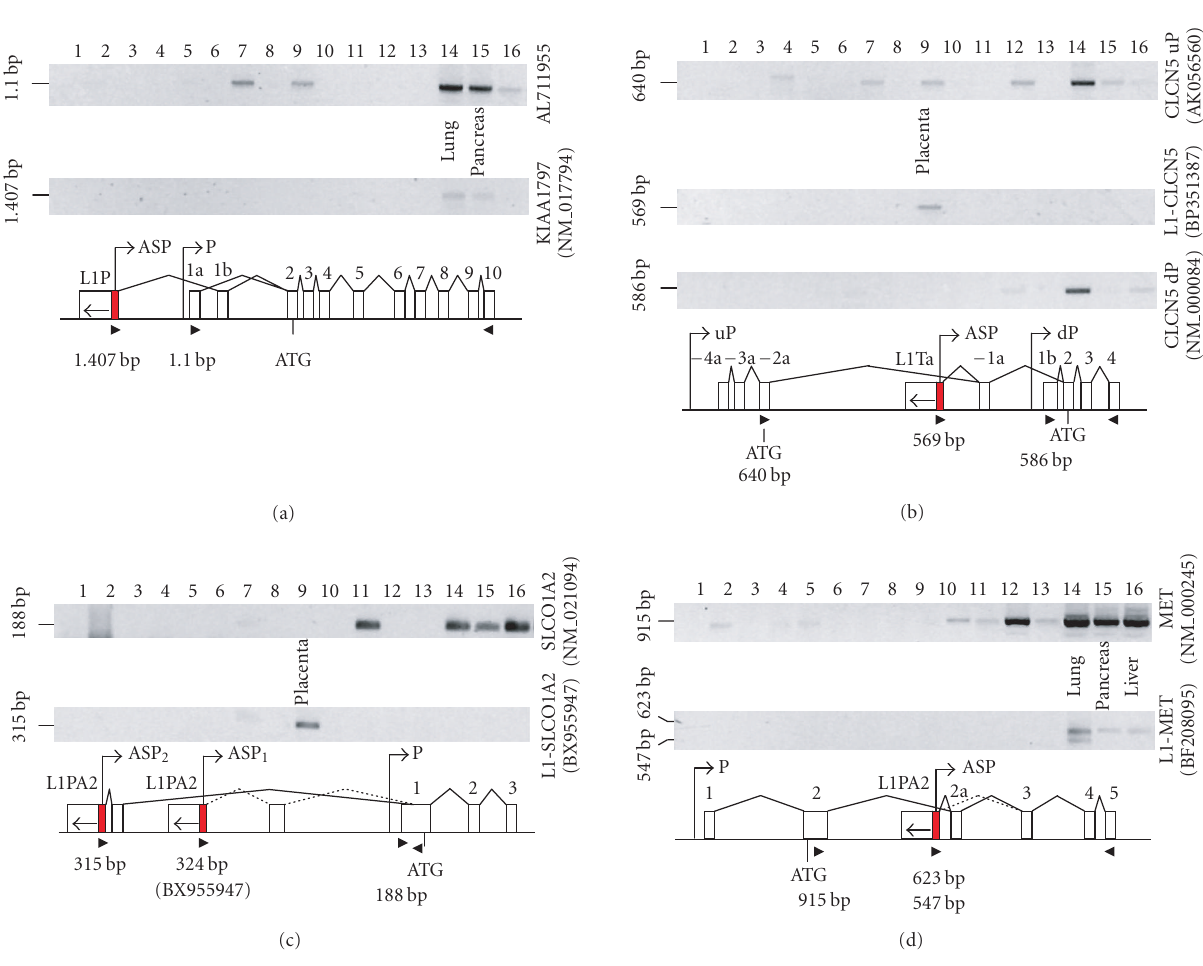
Figure 1: Distribution of chimeric mRNAs derived from the L1 ASP as an alternative promoter. The presence of native mRNAs derived from a gene predicted by (a) AL711955 and KIAA1797 , (b) CLCN5 [25], (c) SLCO1A2 , (d) MET proto-oncogene [26], and their corresponding chimeric transcripts is shown at the upper and lower RT-PCR panels. cDNAs were derived from the following human tissues: 1, thymus; 2, prostate; 3, spleen, 4, small intestine; 5, colon; 6, ovary; 7, testis; 8, peripheral blood leukocytes; 9, placenta; 10, skeletal muscle; 11, brain; 12, kidney; 13, heart; 14, lung; 15, pancreas, and 16, liver. GenBank accession numbers for each mRNA and chimeric L1 mRNA are shown. Product sizes are shown on the left of each panel and below the forward primer on the scheme. L1 (PA2 or Ta subfamily) is shown by a large box with the 5 (cid:2) UTR region indicated in red and its orientation is marked by an arrow. Exons are marked by open boxes (not in scale). Splicing schemes are shown by lines. The location of translation initiation, codon is marked by ATG. Primers used in PCR are shown by arrowheads below the exons. (b) Exons transcribed from the CLCN5 upstream promoter [uP] are designated with − 1a to − 4 a. (c) A 315 bp RT-PCR product corresponds to L1- SLCO1A2 transcript derived from the upstream L1 ASP (L1 ASP 2 ), but not from the L1 ASP (L1 ASP 1 ) predicted by the EST (BX955947). (d) A minor L1- MET splice variant is shown by a broken line. P stands for promoter and dP stands for downstream